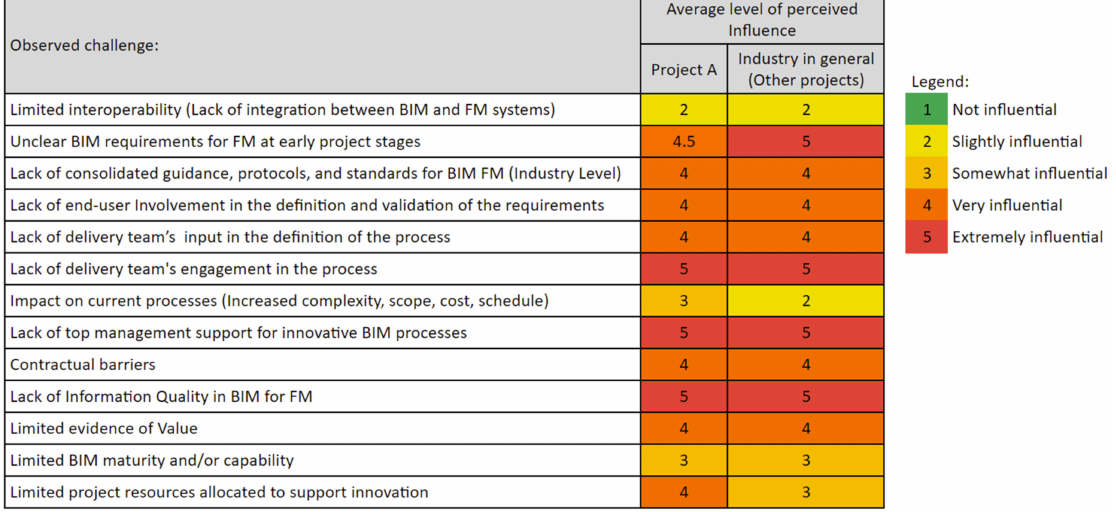
Figure 16. Average level of perceived influence of each identified challenge for the successful implementation of BIM for